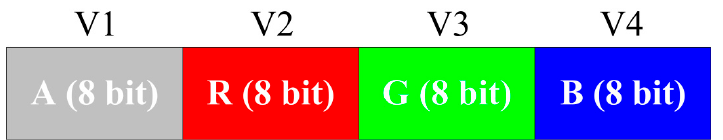
Figure 2. A single pixel of a 32 ‐ bit RGB format is split into four equal portions for representing four variables (V1, V2, V3 and V4). A, R, G and B represents the alpha, red, green and blue portions of the pixel, respectively.